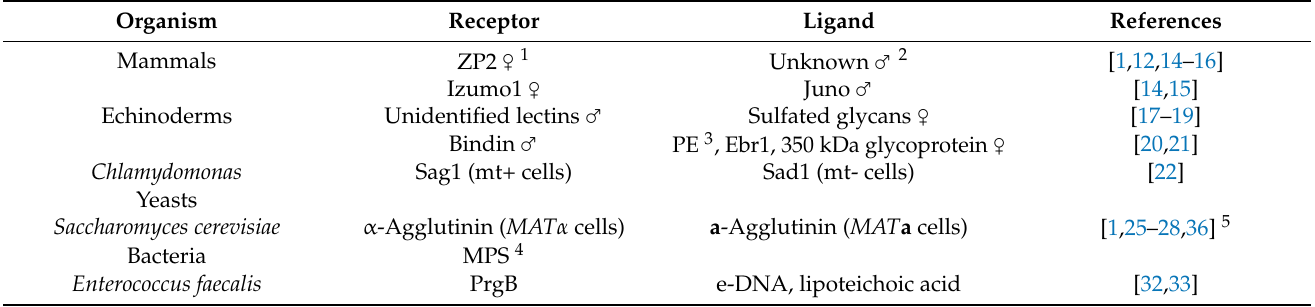
Table 1. Adhesion systems in